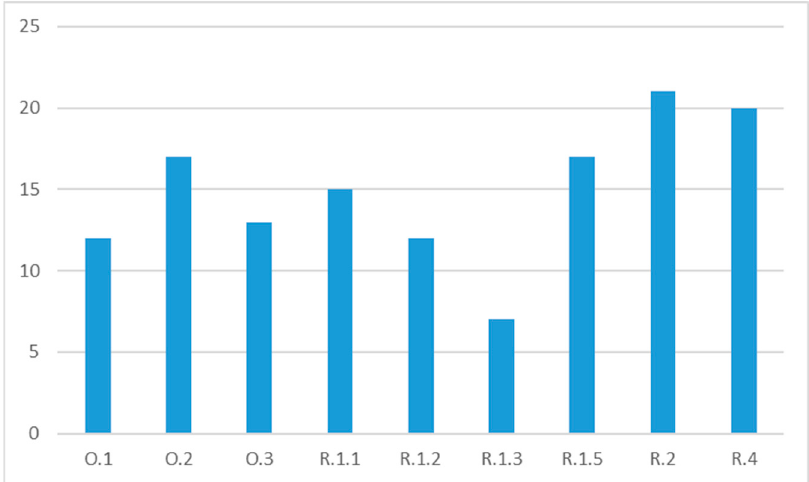
Figure 1. Number of mentions by